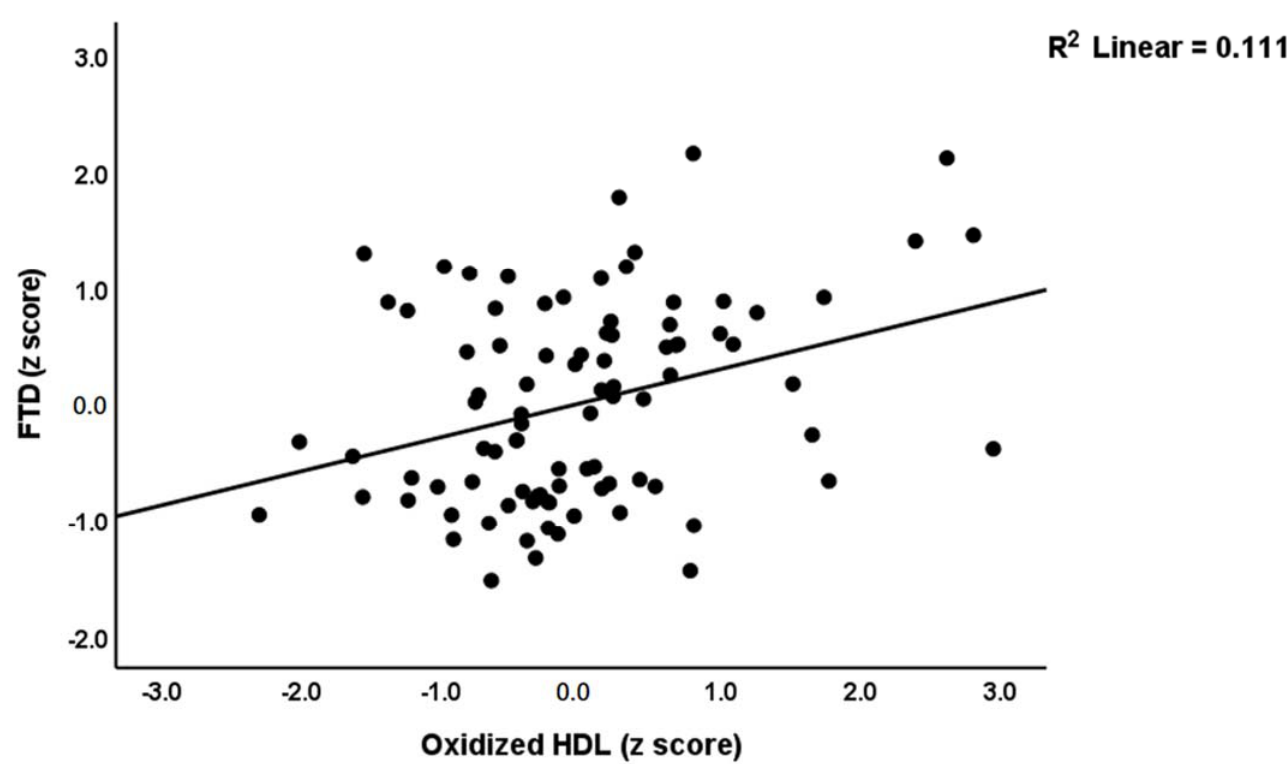
Figure 3. Partial regression plot of formal thought disorders (FTD) on serum oxidized high density lipoprotein (HDL) levels.